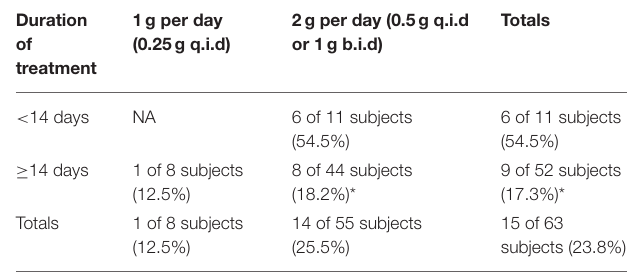
TABLE 3 | Percent relapse (streptomycin follow-up treatment) in operation whitecoat subjects exposed to aerosolized F. tularensis Schu S4. Duration of treatment